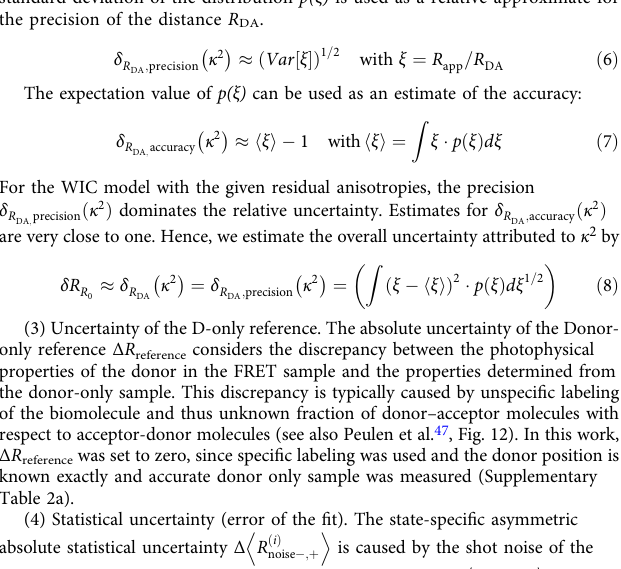
absolute statistical uncertainty Δ R ð i Þ noise (cid:2) ; þ lifetime measurements (listed in Supplementary Table 2g). Δ R ð i Þ noise (cid:2) ; þ